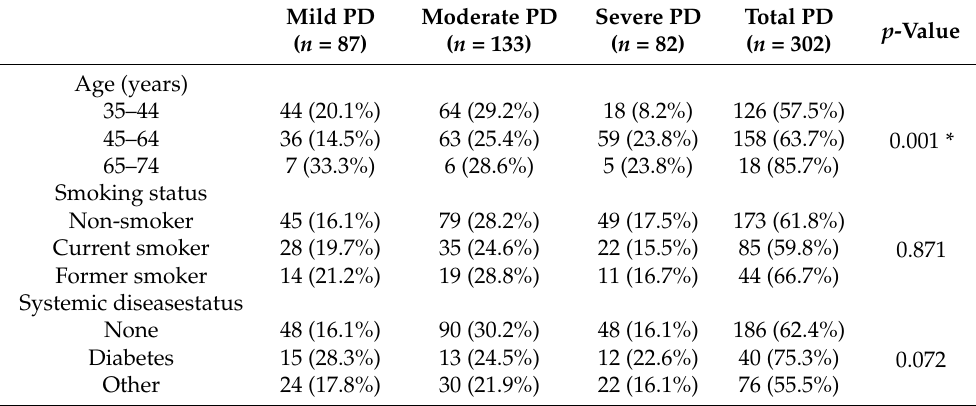
Table 1. Prevalence of periodontitis by the characteristics of the CDC/AAP (American Academy of Periodontology/Centers for Disease Control and Prevention) case